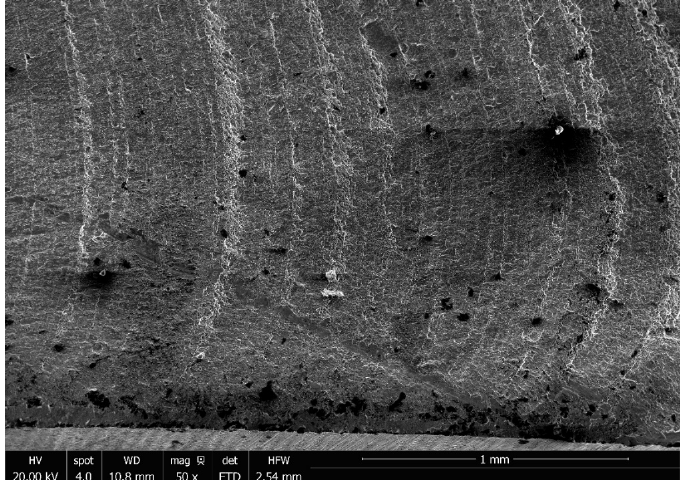
Figure 11. Topographical SEM image of the fracture surface with beach marks.